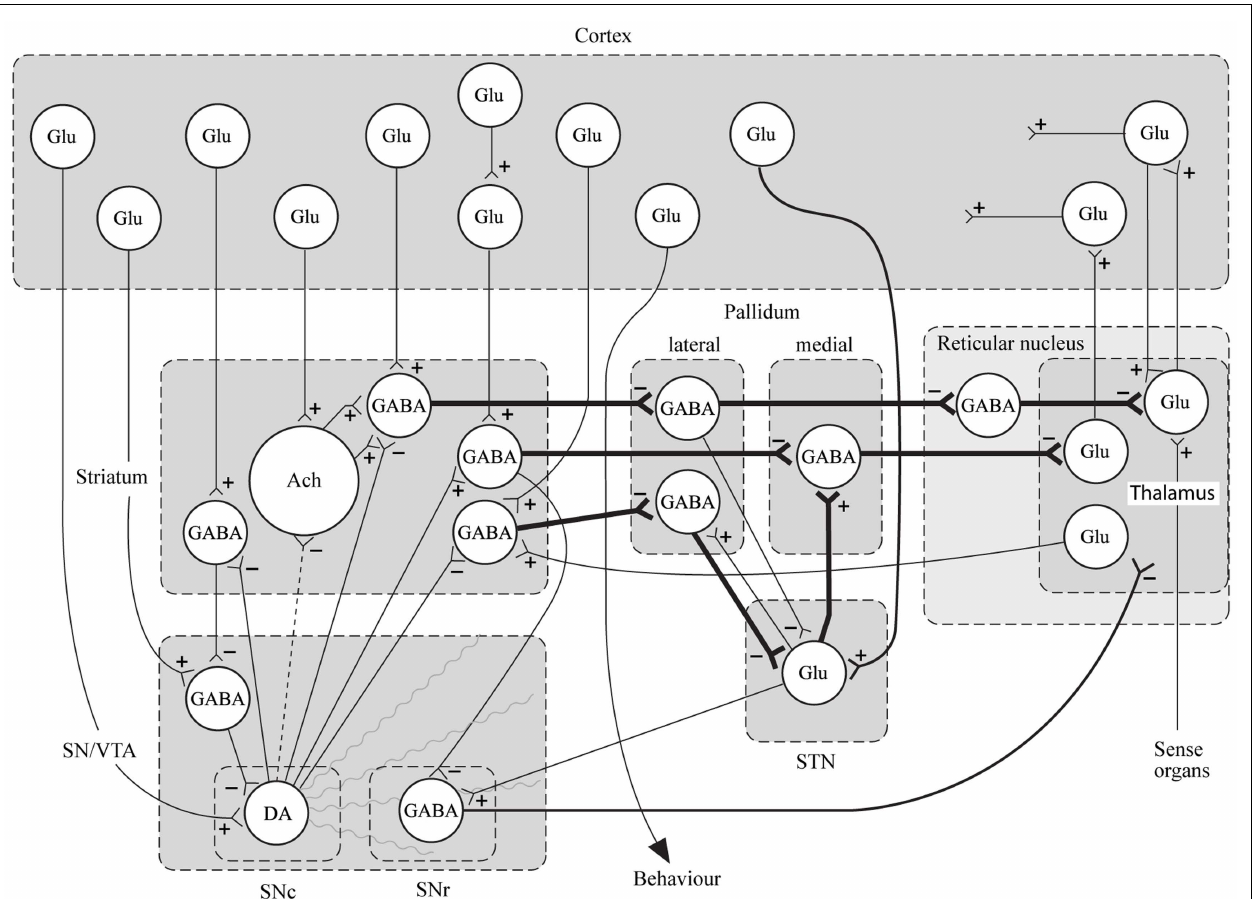
gabaergic neurons and is referred to as “direct.” Key: SN, substantia nigra; VTA, ventral tegmental area; STN, subthalamic nucleus; Glu, glutamate; Ach, acetylcholine; DA, dopamine [With Permission Carlsson et al. (1999) and Biological